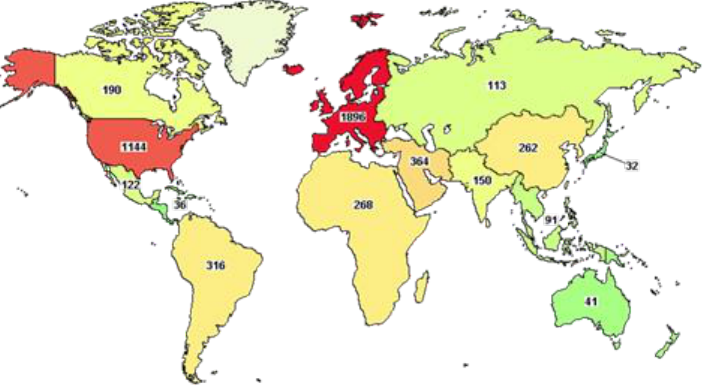
Figure 6. Map of COVID19 clinical trials. This map has been obtained by using clinicaltrial.gov searching for COVID-19 clinical trials for the age 65 and above.